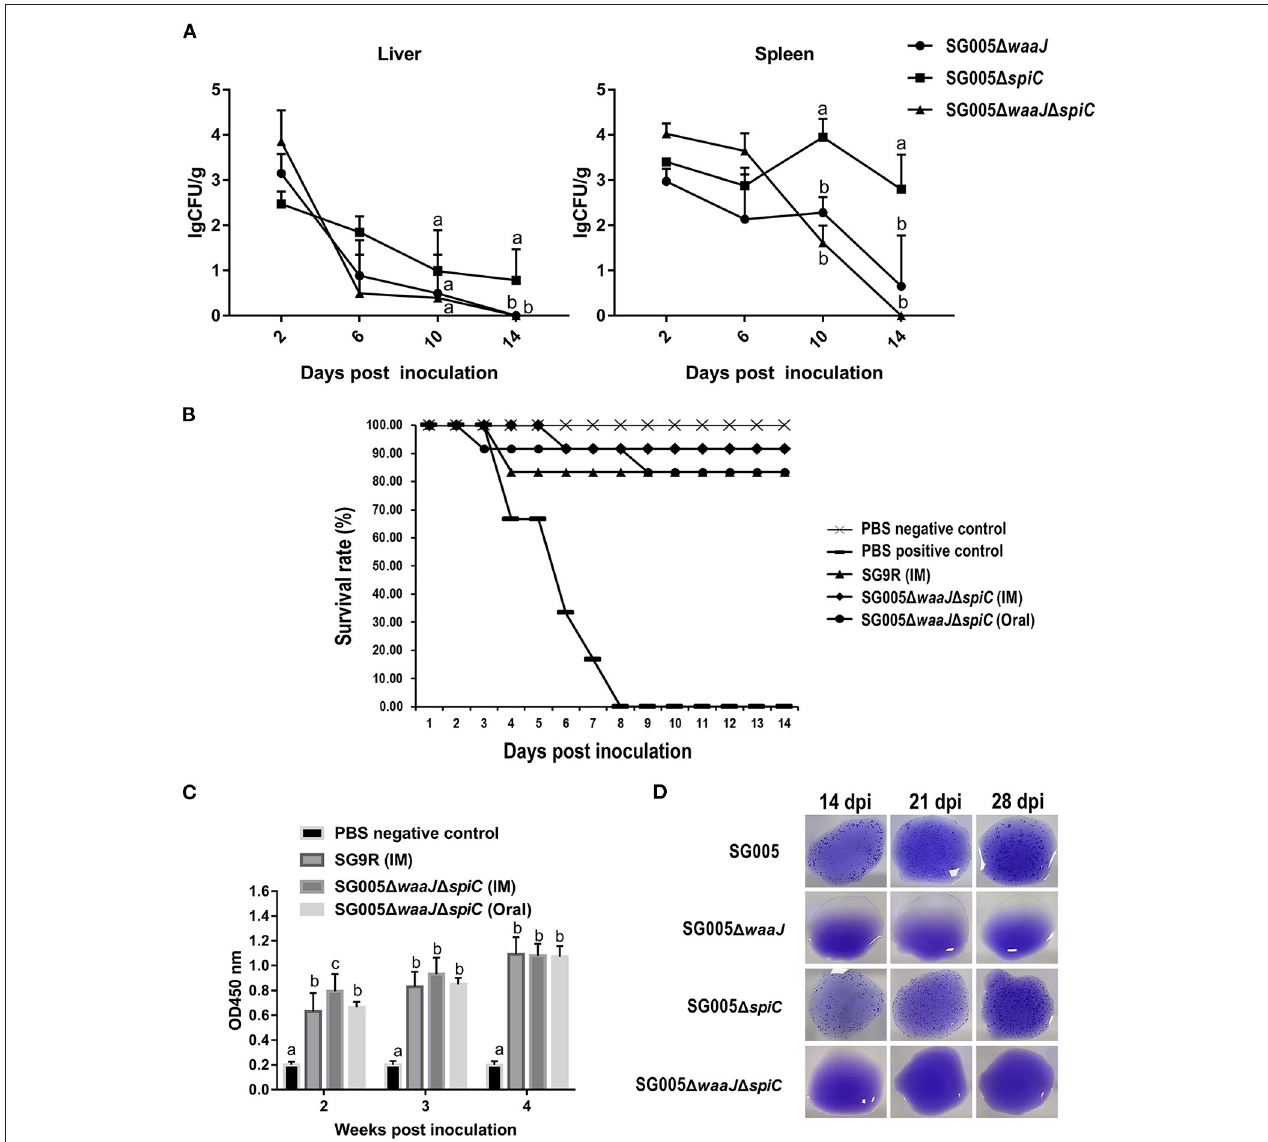
FIGURE 4 | Organ colonization, protective efficacy, humoral immune response, and DIVA capability analysis. (A) Colonization and persistence of the deletion strains in the liver and spleen after inoculation of 7-day-old chickens with 10 8 CFU bacterial cells. Values were represented as lgCFU/g sample. All broilers inoculated with SG005 died within 3 days, and the number of bacteria isolated from the liver and spleen was about 8 lgCFU/g. (B) Protective ability of the deletion strains against the virulent SG005 challenge. At 14 dpi, chickens from each group were challenged intramuscularly with 1 × 10 8 CFU wild-type SG005. Protection was expressed by percentage survival after challenge. SG9R was used as a vaccine control. (C) Levels of humoral immune responses in vaccinated vs. control chickens. Serum IgG antibody responses against the deletion strains were measured by indirect ELISA. OD 450 , optical density at 450nm. The OD 450 average value of negative serum samples plus the standard deviation (SD) of three times was used as the cut-off value, which was found to be 0.281. (D) Capability of DIVA based on a serum plate agglutination test. Sera collected on 14, 21, and 28 dpi were tested for reactivity to the S. enterica ser. Pullorum/Gallinarum standard antigen. Statistical analysis was done using one-way ANOVA. Different letters mean significant differences between groups ( P <